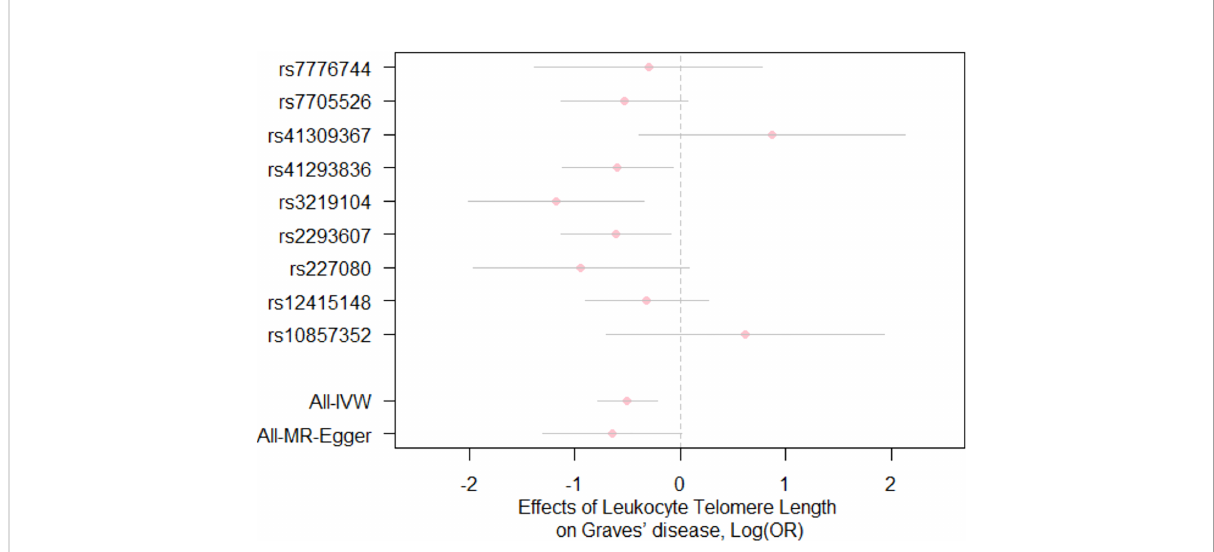
FIGURE 3 Forest plot for the effects of SNPs on telomere length and Graves ’ disease. Each pink dot and grey bar represent the effect estimate and 95% CI for each SNP, respectively. The overall effect estimates and 95% CI are indicated by using the IVW and MR-Egger approaches. IVW, inverse variance weighted; MR, Mendelian randomization; OR, odds ratio; SNPs, single nucleotide polymorphisms; CI, con fi dence